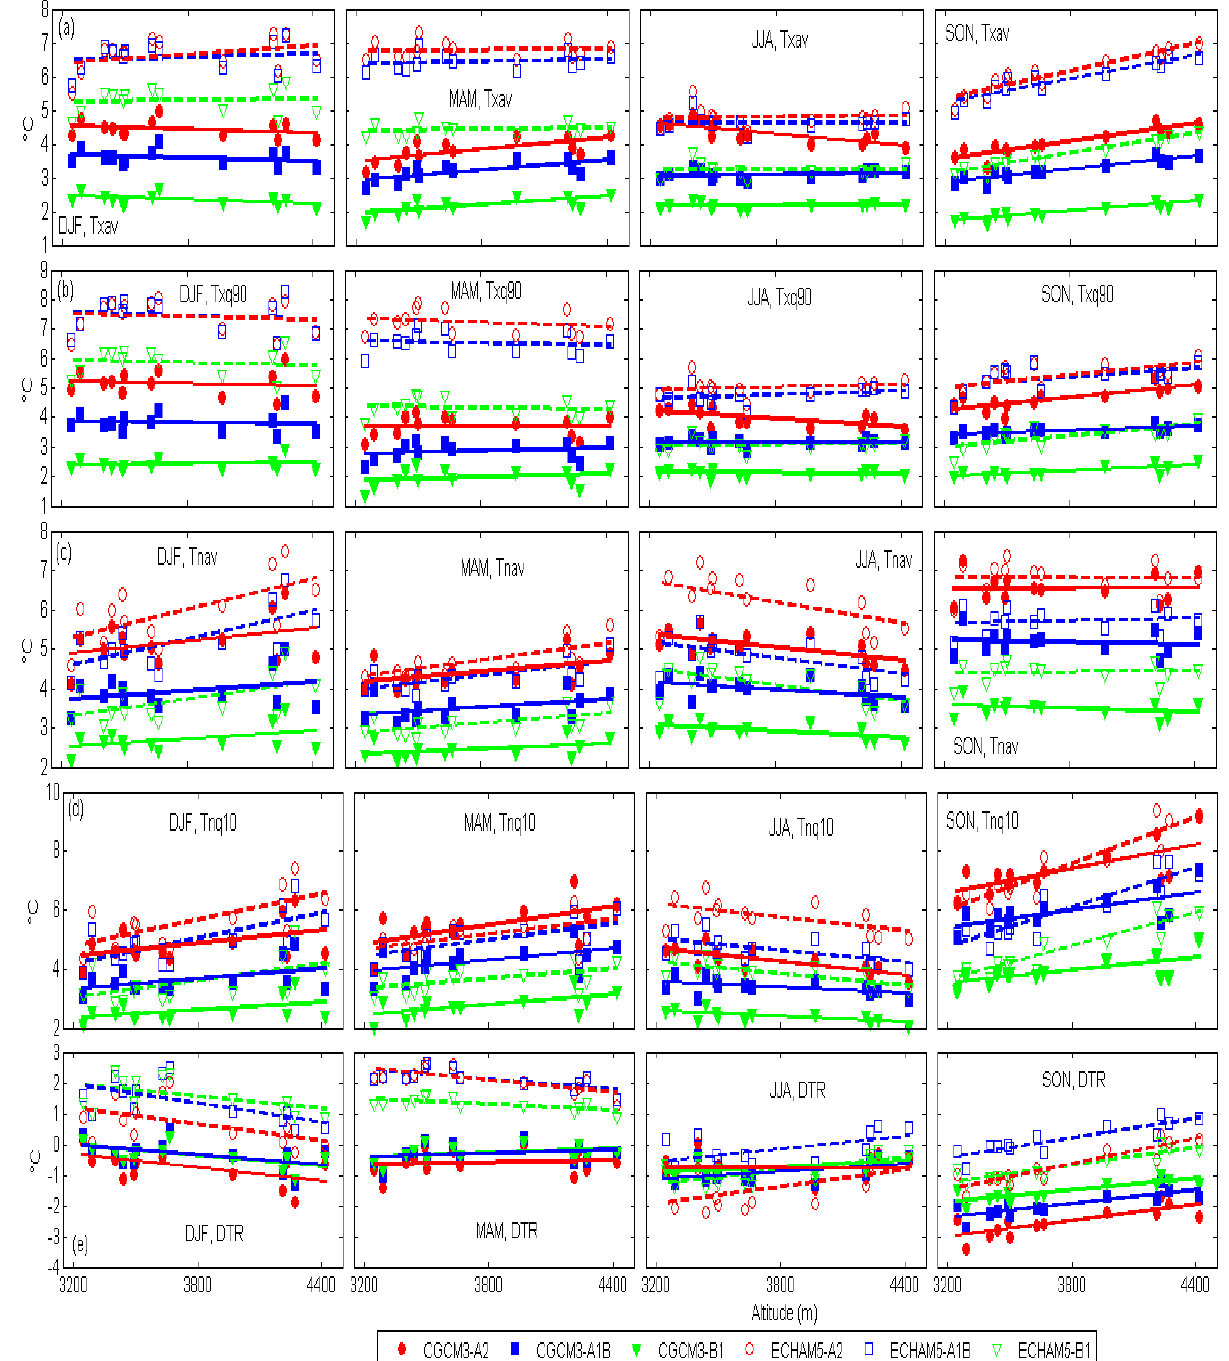
Fig. 6. Projected anomalies of the intensity-related indices (between 2081–2100 and 1961–1990) with station altitude for four seasons based on statistical downscaling outputs of two GCMs (CGCM3 and ECHAM5) under three emission scenarios (A2, A1B and B1). lesser rate (0.23–0.73 ◦ C per km) (Fig. 6b). A similar